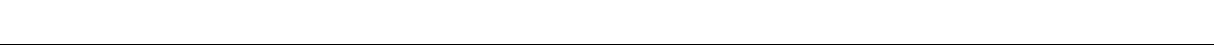
FIGURE2| PXRDpatternsoftheproductssynthesizedatgivenpreparationstep(seelegend).Patternswereindexedto Fd